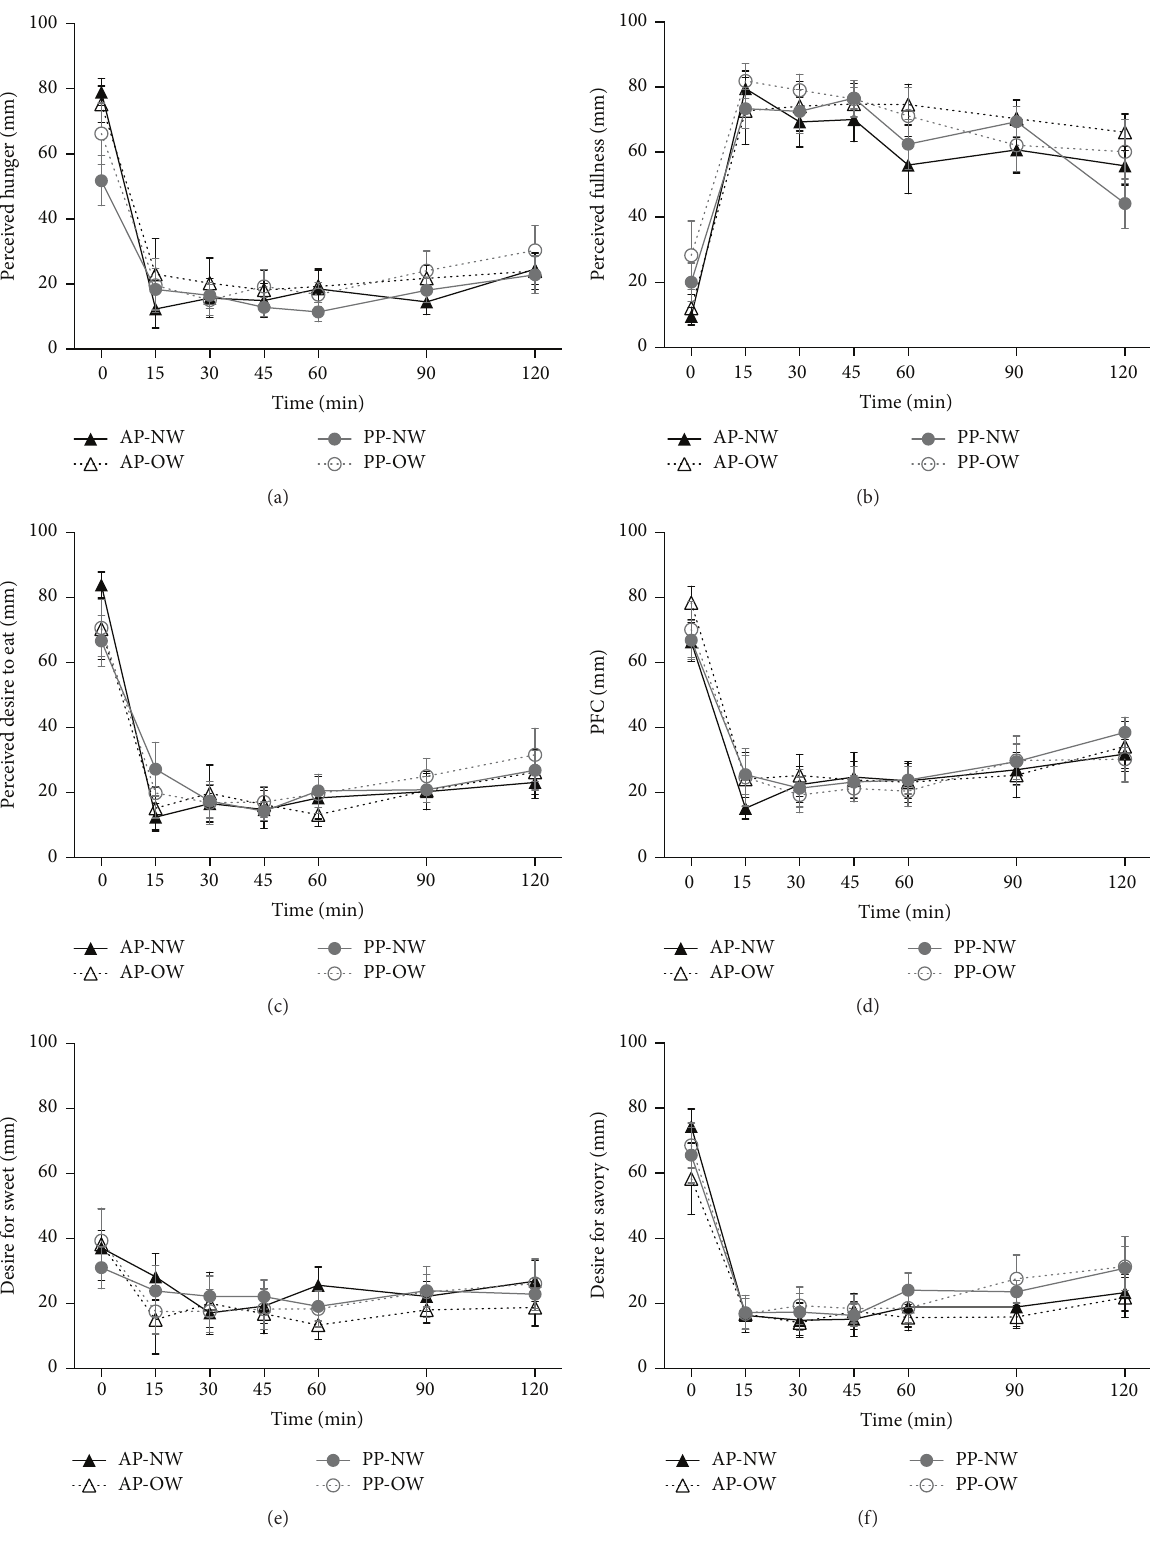
Figure 2: Appetite responses following test breakfasts. Values expressed as means ± SEM. Data are depicted as appetite rating over time per weight group and breakfast type and net incremental area under the curve (niAUC). (a) Perceived hunger. (b) Perceived fullness. (c) Perceived desire to eat. (d) Prospective food consumption. (e) Desire for something sweet. (f) Desire for something savory. AP: animal protein; NW: normal weight; OW: overweight; PP: plant